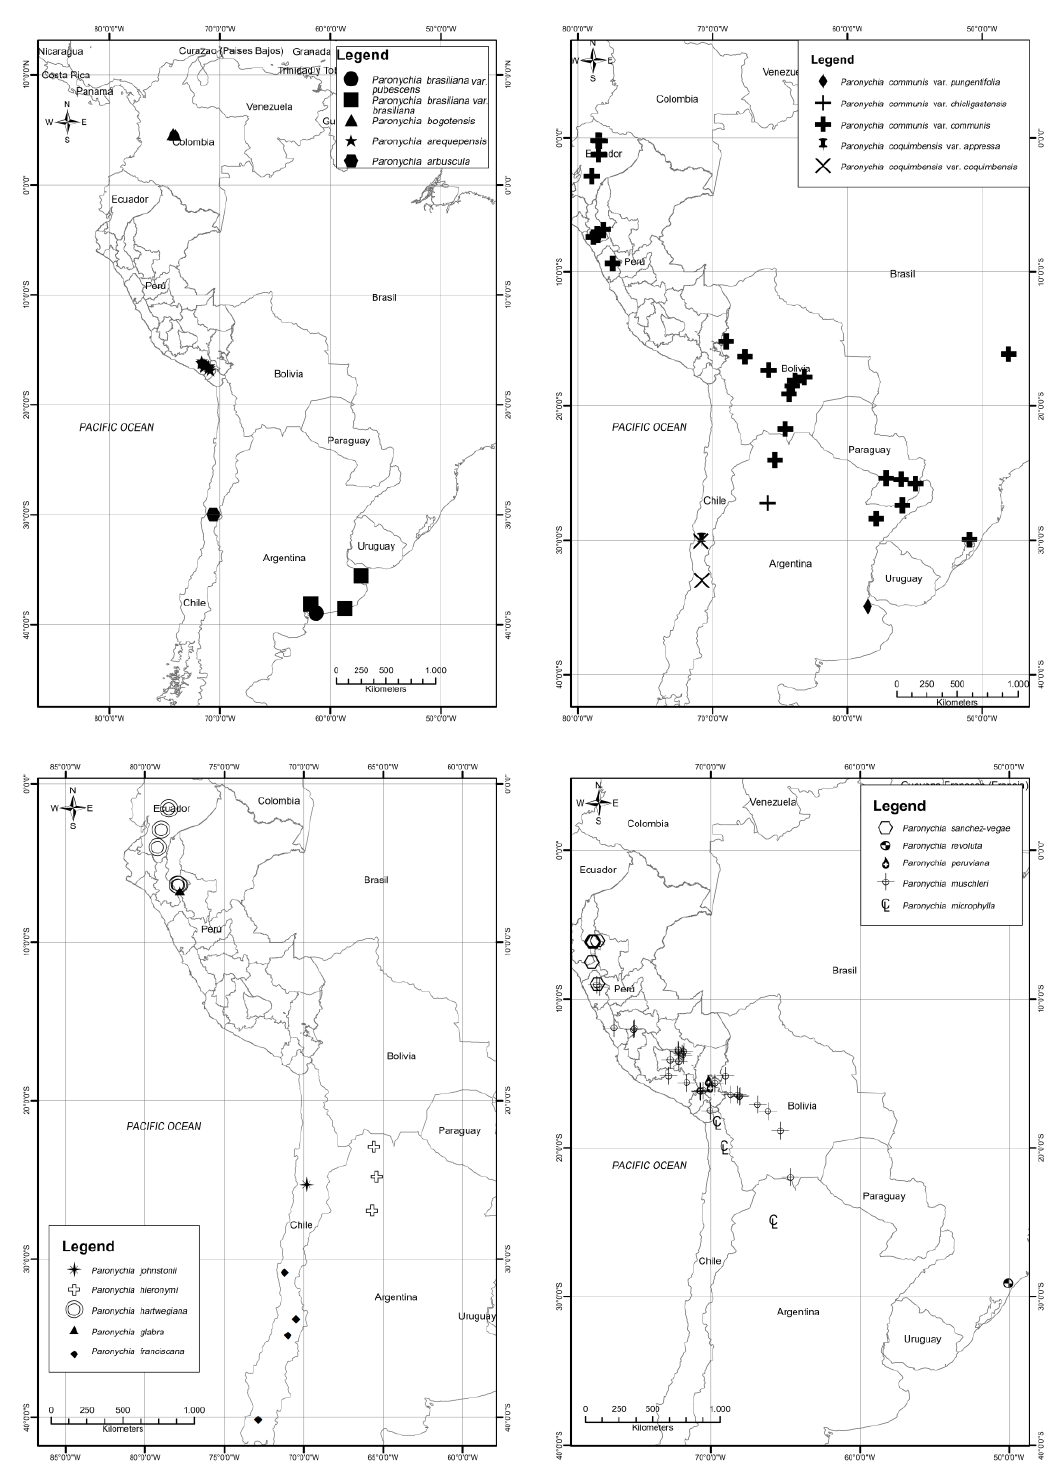
Figure 1/2. Distribution maps of Paronychia species occurring in South America. Figure 1. Cont